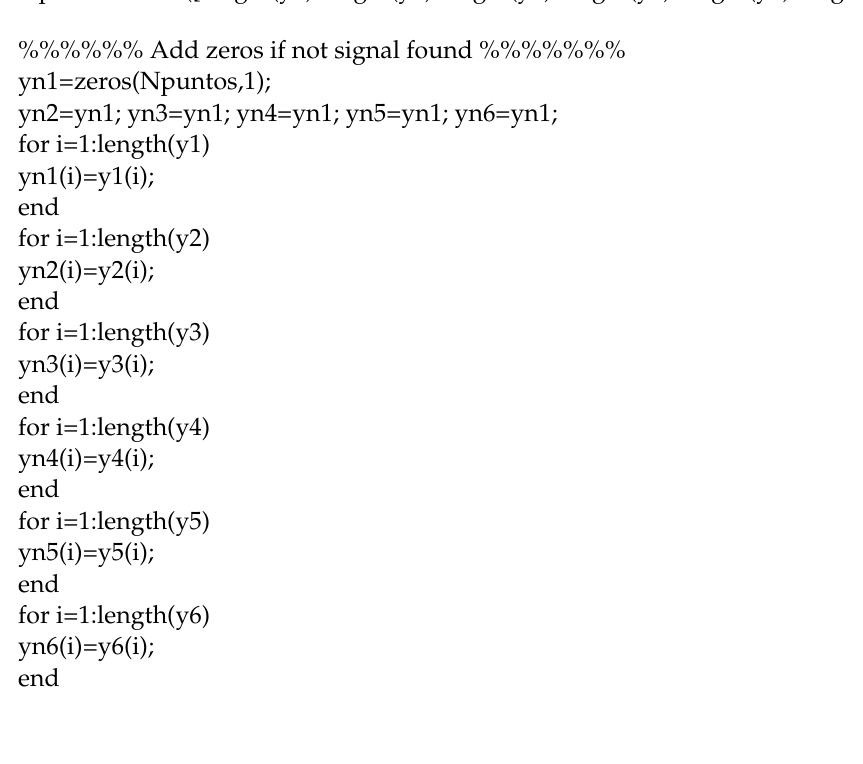
BLUE175_15T; Figure S13: Briquette obtained in Experiment 12: GREY180_10T; Figure S14: Bri- quette obtained in Experiment 13: BLUE180_5T; Figure S15: Briquette obtained in Experiment 14: GREY175_15T; Figure S16: Briquette obtained in Experiment 15: BLUE180_15T; Figure S17: Micro- graphs of the different briquettes obtained with the blue mattress and of the mattress itself; Figure S18: Micrographs of the different briquettes obtained with the grey mattress and of the mattress itself; Figure S19: Reduction index versus porosity; Figure S20: Reduction index versus apparent density; Figure S21: Reduction index versus compactness